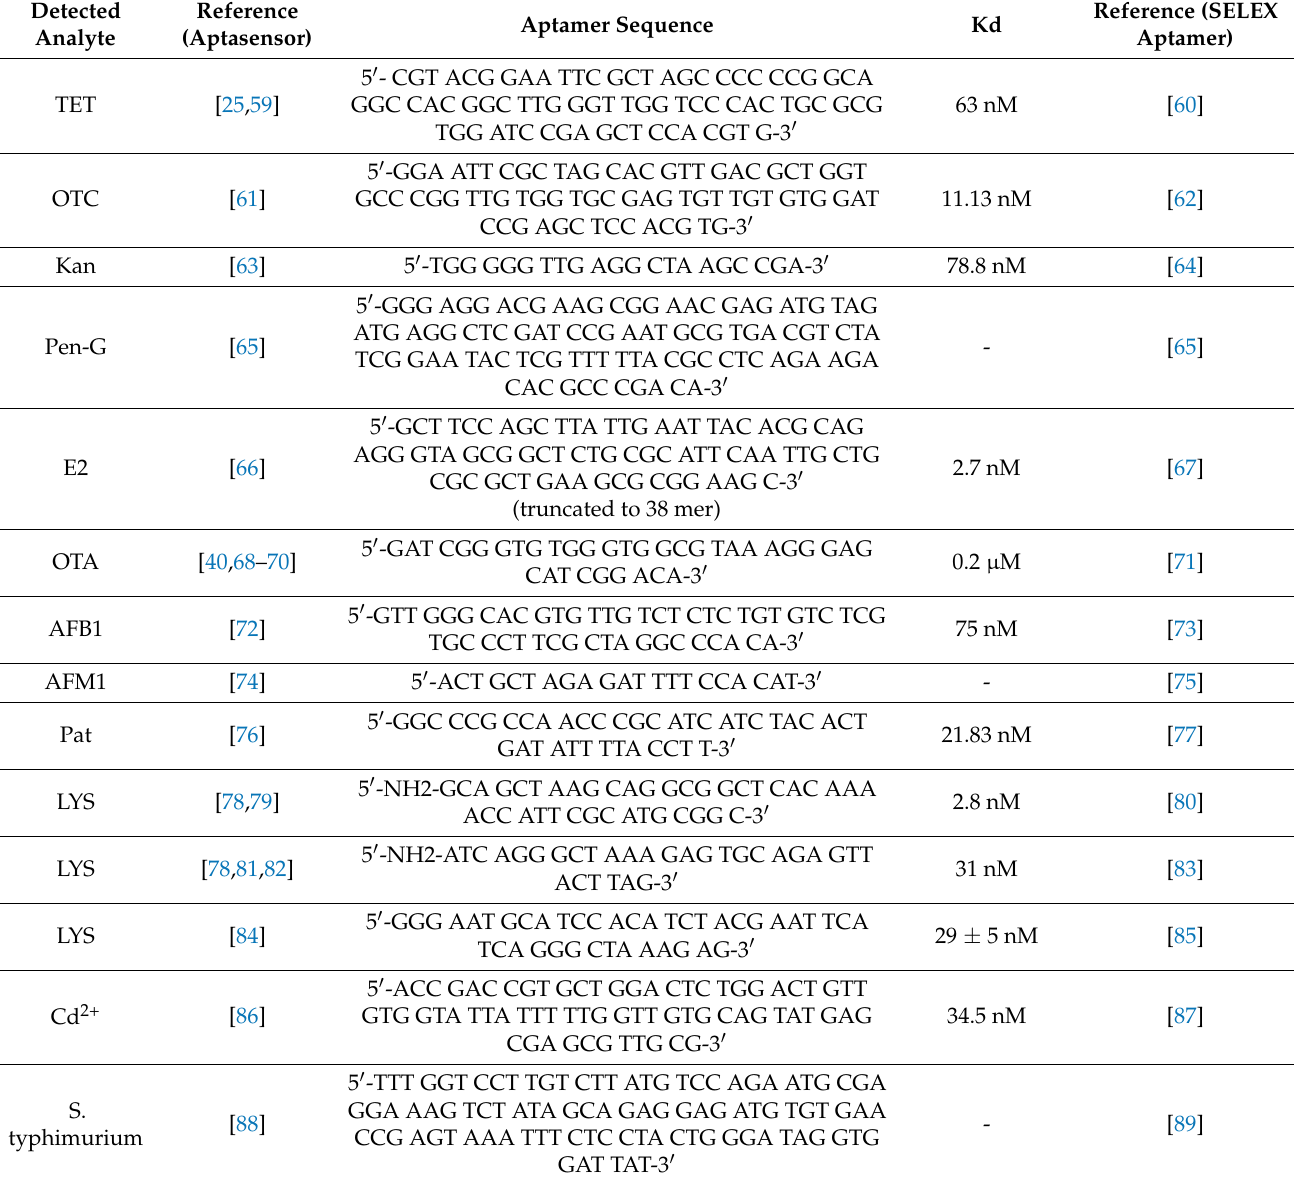
Table 1. Aptamer sequences obtained through SELEX technology and employed in the fabrication of electrochemical aptasensors for food